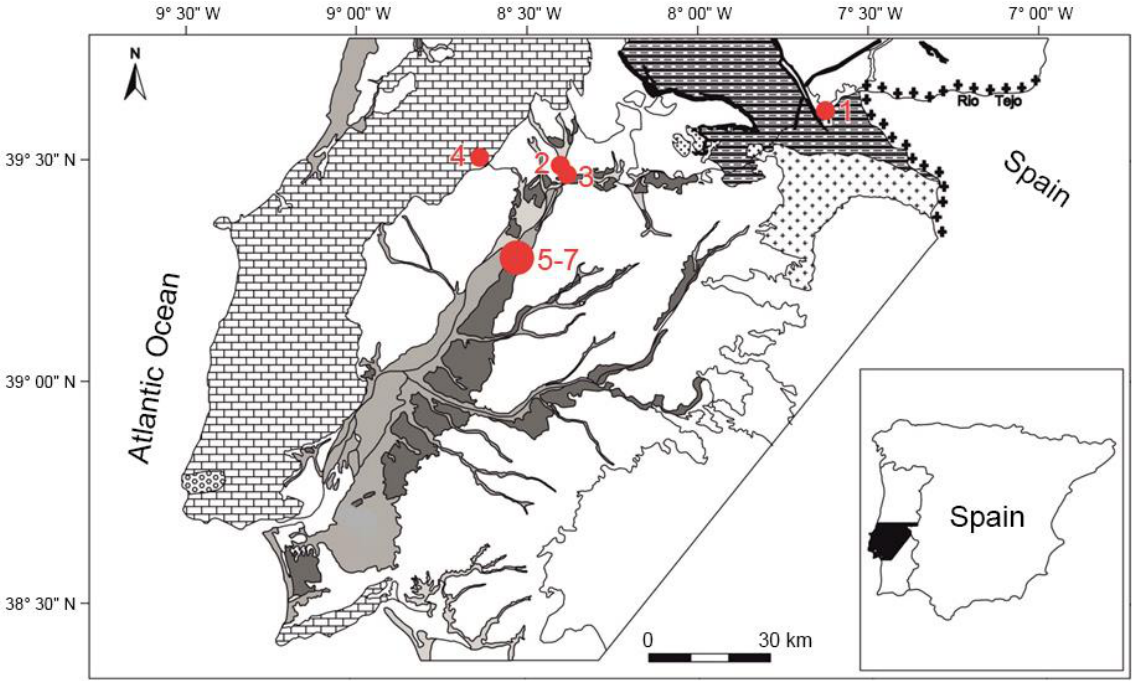
Figure 1. Sites in Central Portugal mentioned in the text: 1. Monte Famaco; 2. RPP; 3. Fonte da Moita; 4. Aroeira; 5-7. Vale do Forno 1, 3 and